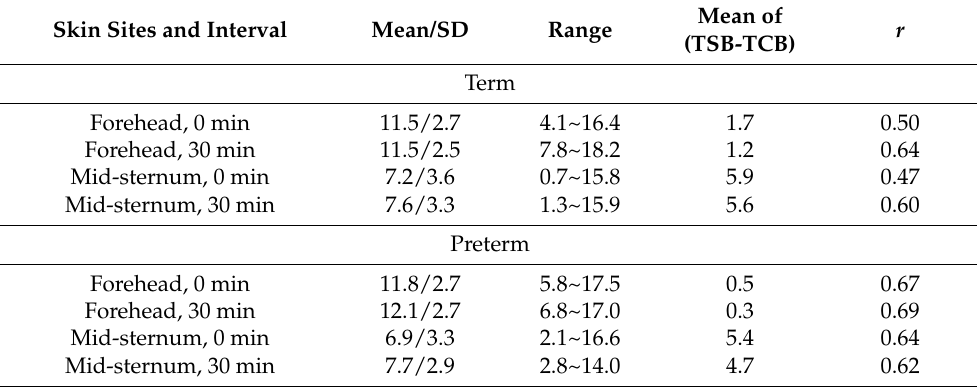
Table 3. Correlation and differences between TCB measurements among different skin sites and intervals after phototherapy compared with TSB data in term and preterm babies.